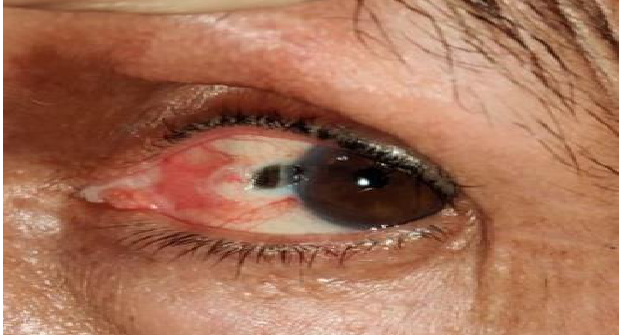
Fig. 1. Near total scleral & corneal thinning ten days after surgery.